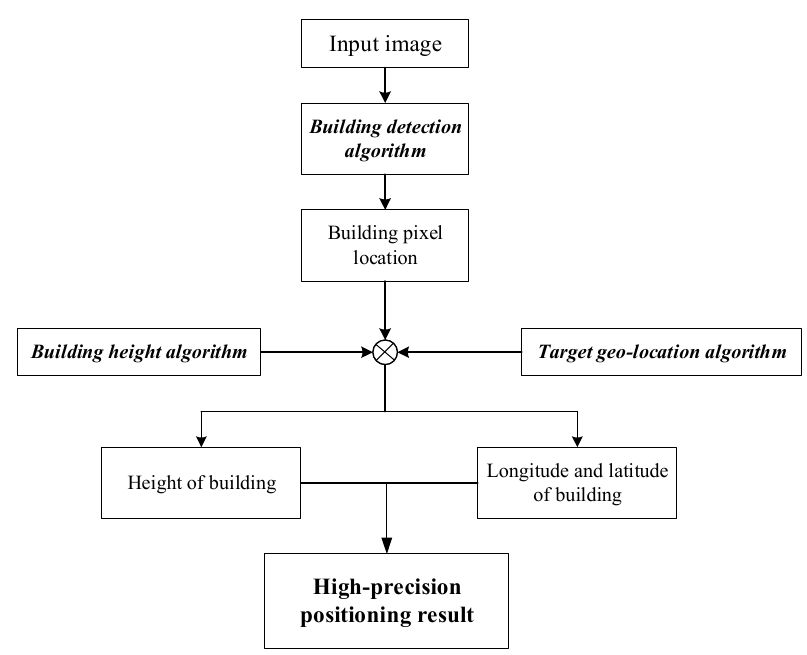
Figure 11. Flow chart of the building target location algorithm.